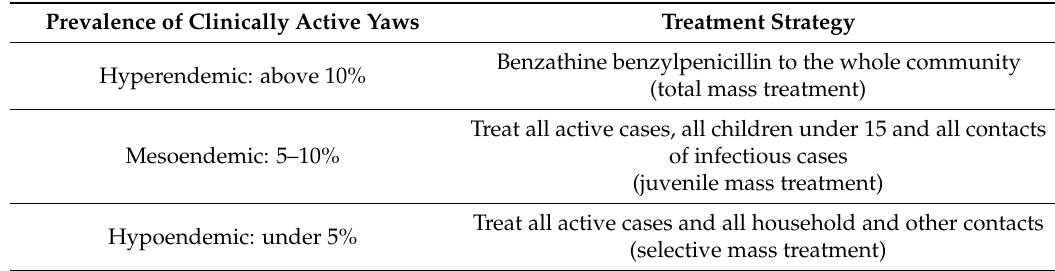
Table 1. Historical strategy for the eradication of yaws: